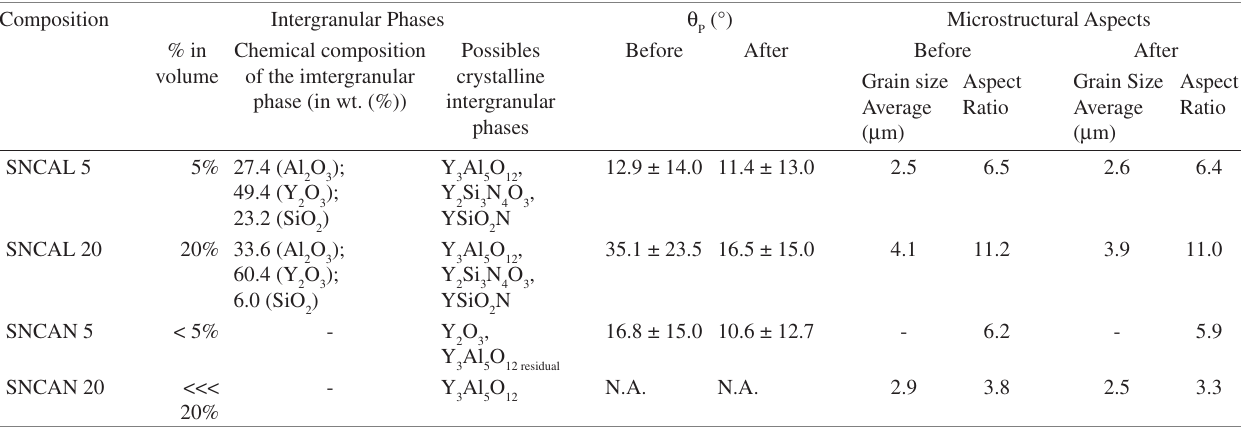
Table 4. Typical characteristics of the intergranular phases, microstructures and crystalline phases of the crept samples. Composition Intergranular Phases θ % in Chemical composition volume of the imtergranular phase (in wt. (%))